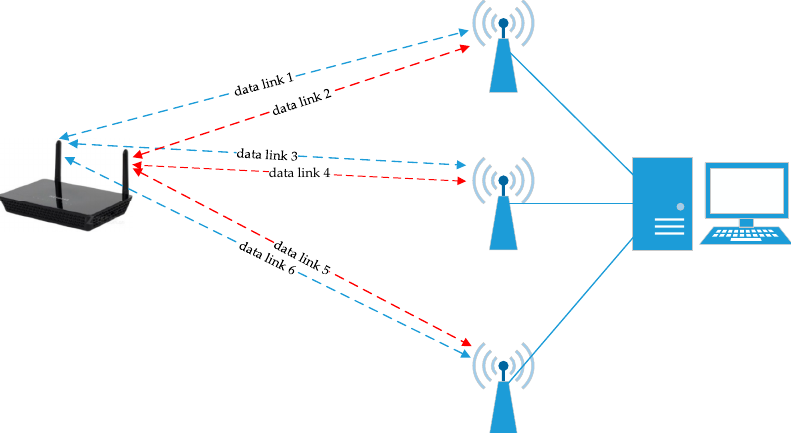
Figure 2. CSI-MIMO antenna pairs. MIMO: multiple-input multiple-output.